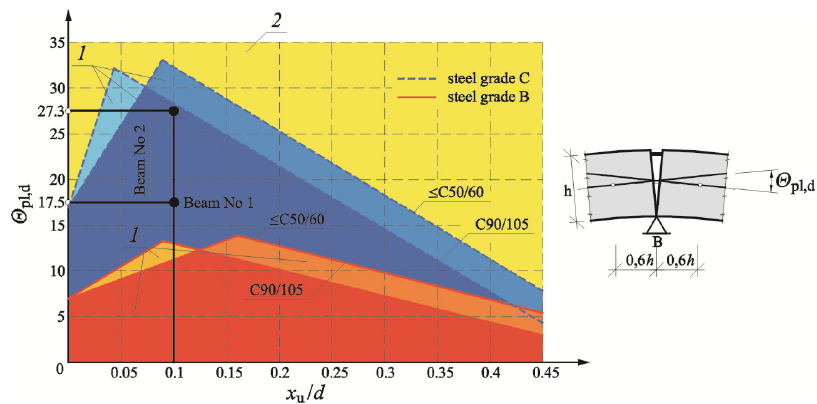
Figure 23. Comparison of measured values for relative rotations of sections and allowable values specified in the standard EN 1992–1–1:2010 [57]; 1—allowed rotation, 2—unacceptable allowed